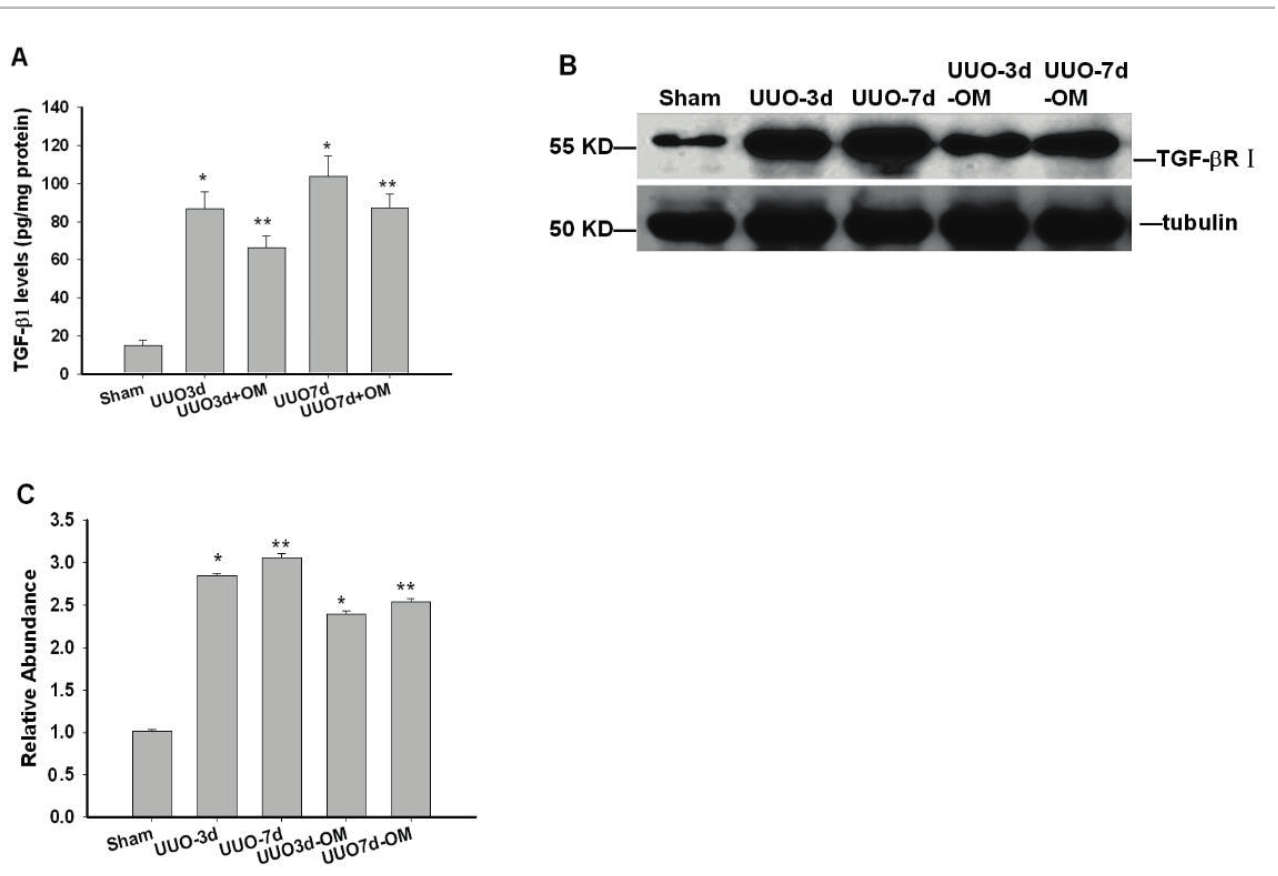
FIGURE 4 - TGF- β 1 protein levels were determined by ELISA in the kidneys at 3d or 7 d after UUO with or without OM treatment and sham group The protein levels of TGF- β 1 type I receptor at 3 d or 7 d after UUO with or without OM. OM reduced the TGF- β 1 and its type I receptor (TGF- β RI) levels of renal tissues in UUO mice. The values are represented as the density of TGF- β RI vs tubulin control. The graph summarizes densitometric analysis of 3 independent technical experiments. *: P<0.05 vs. sham group, **: P<0.05 vs. UUO-3d and UUO-7d group